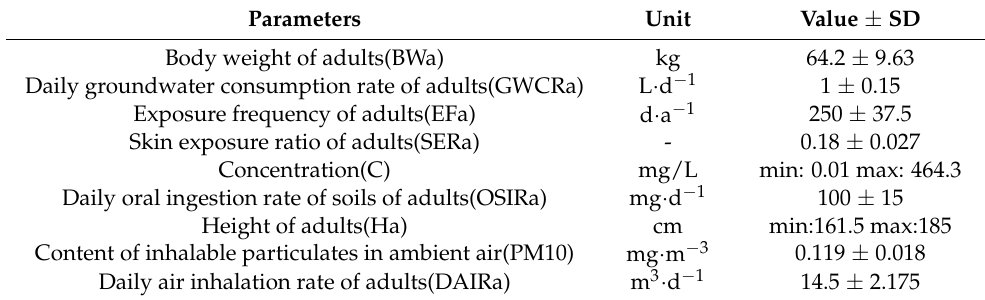
Table 3. Parameters considered for the risk evaluation using Sobol sensitivity approach in the present study. The parameters were selected based on the Technical Guidelines for Risk Assessment of Soil Contamination of Land for Construction and statistical bulletins published by the local authorities and the SD is ± 15% of these values. Parameters Unit Value ± SD Body weight of adults(BWa) kg 64.2 ±